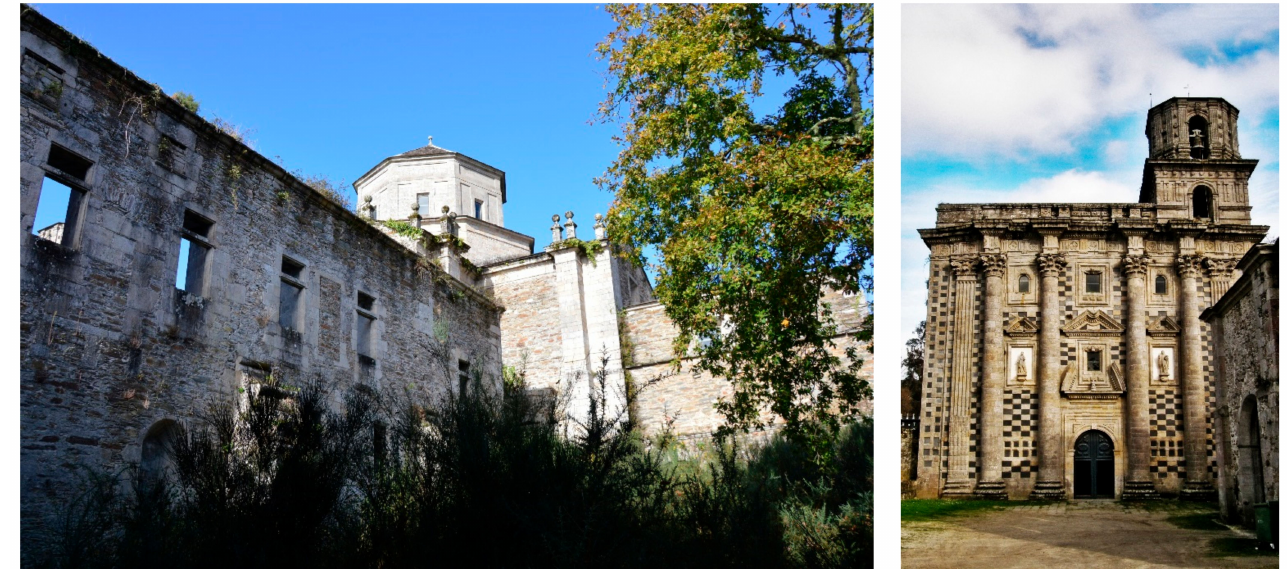
Figure 1. Pictures of the Monastero de Santa Maria de Monfero (source: authors